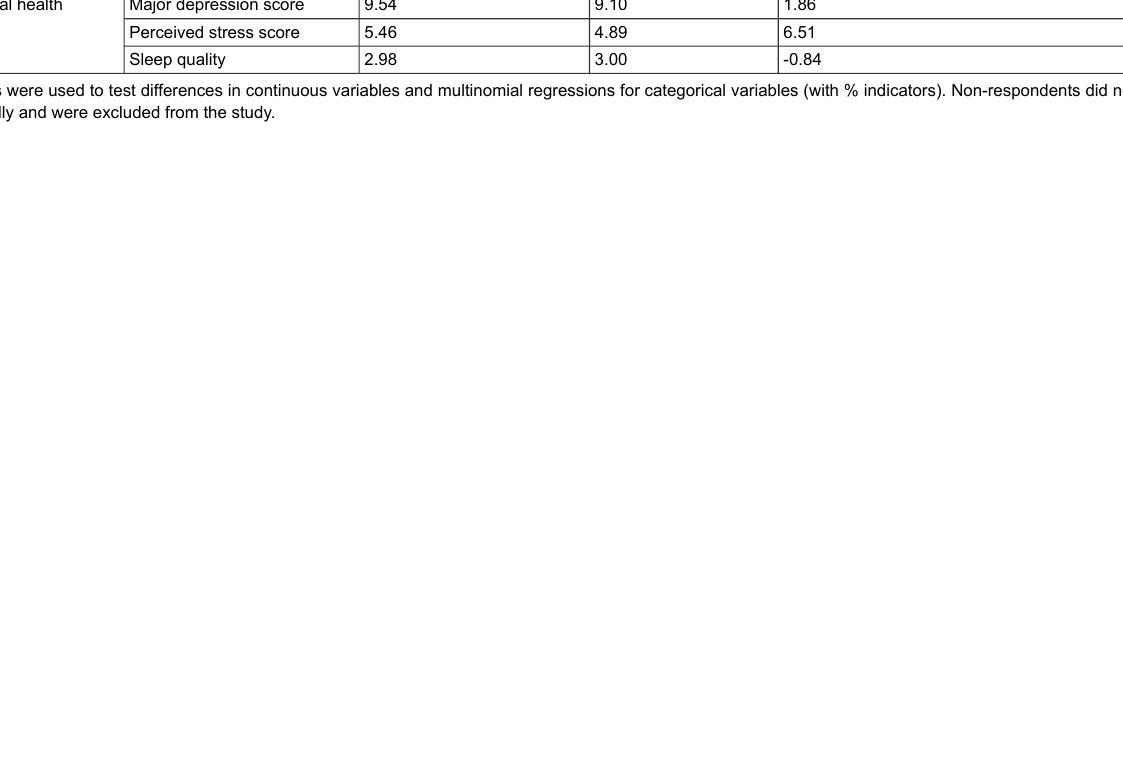
Table S2: Differences in the variables measured at the pre-COVID assessment in non–respondents and respondents in the COVID–19 assessments. Not included in study Included in